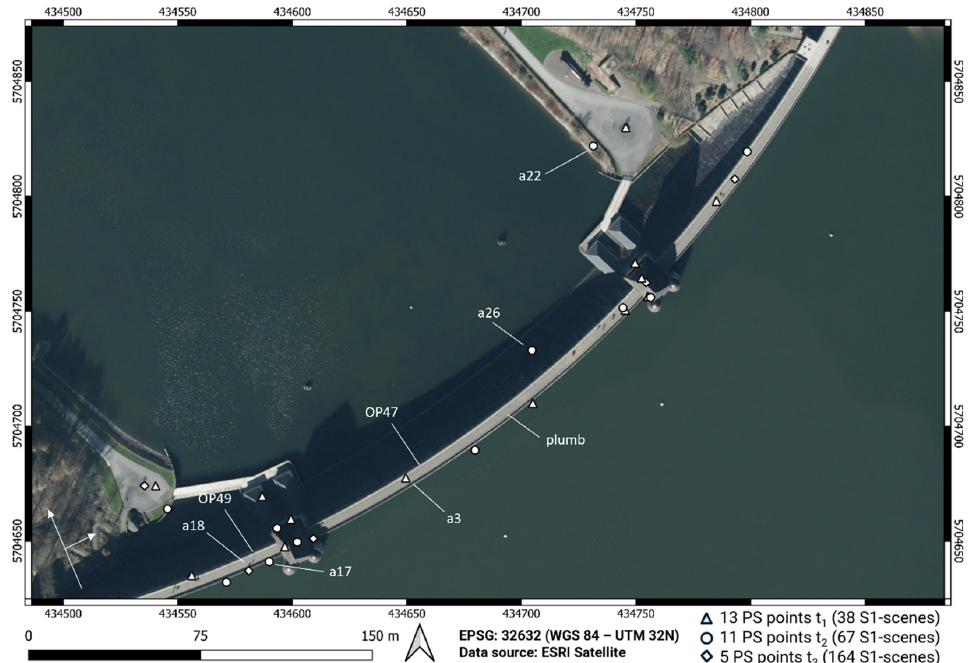
Figure 6. Overview of identified PS points. Shown are the points from all three data stacks of the ascending orbit (t 1 , t 2 , t 3 ) combined as well as the locations of the relevant trigonometric measurements (OP47, OP49) and the plumb measurement. Sensor direction and beam direction of the ascending orbit are represented by two arrows in the lower left corner. Background image: ESRI Satellite.